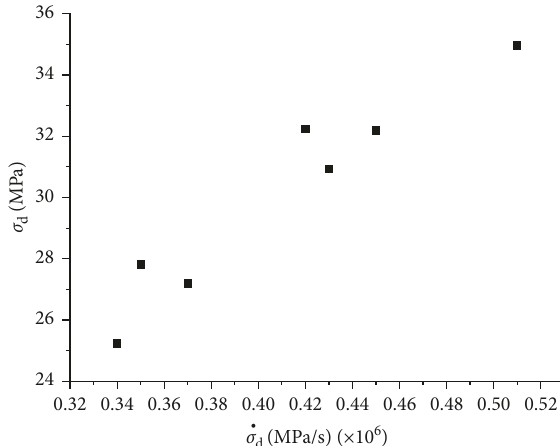
Figure 8: Relationship between dynamic tension strength and loading rate at depth